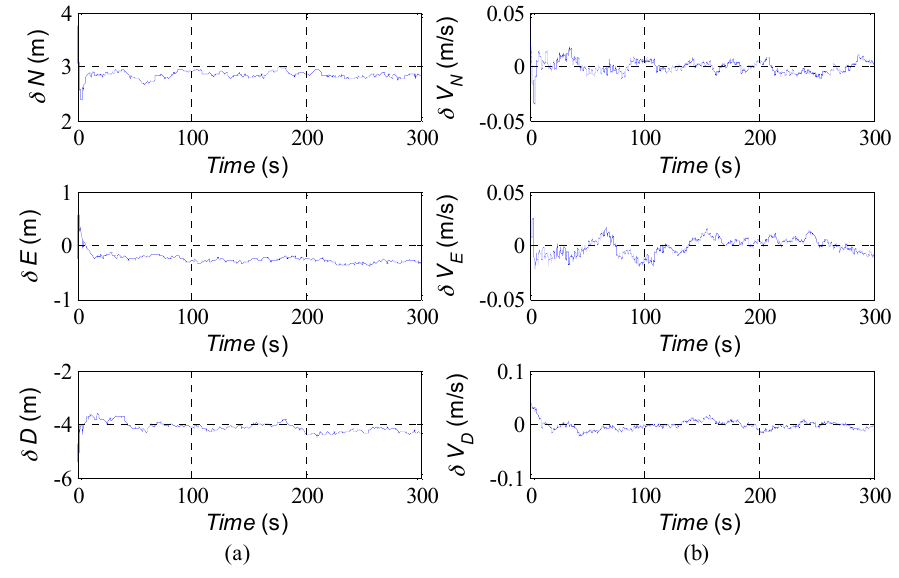
Figure 4. ( a ) estimation errors of the position; ( b ) estimation errors of the velocity.